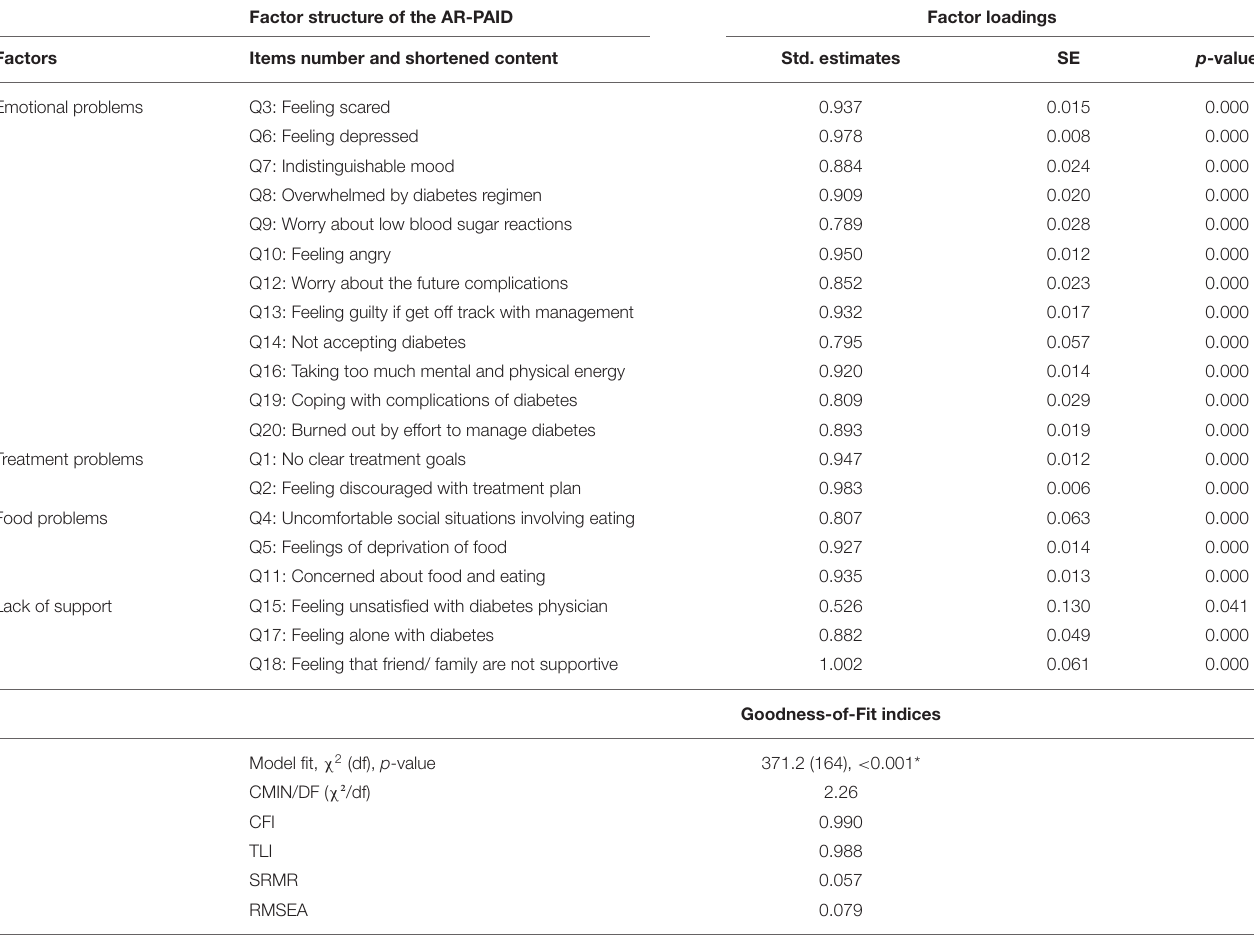
TABLE 3 | Factor loadings of the revised 4-factor model of the AR-PAID ( N = 200).